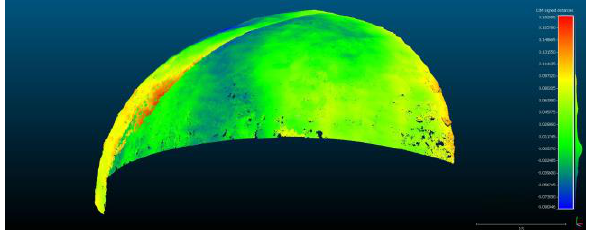
Figure 16. Cloud-to-mesh distances comparison between the dense cloud (1971 dataset) and the sphere interpolated in 2010.